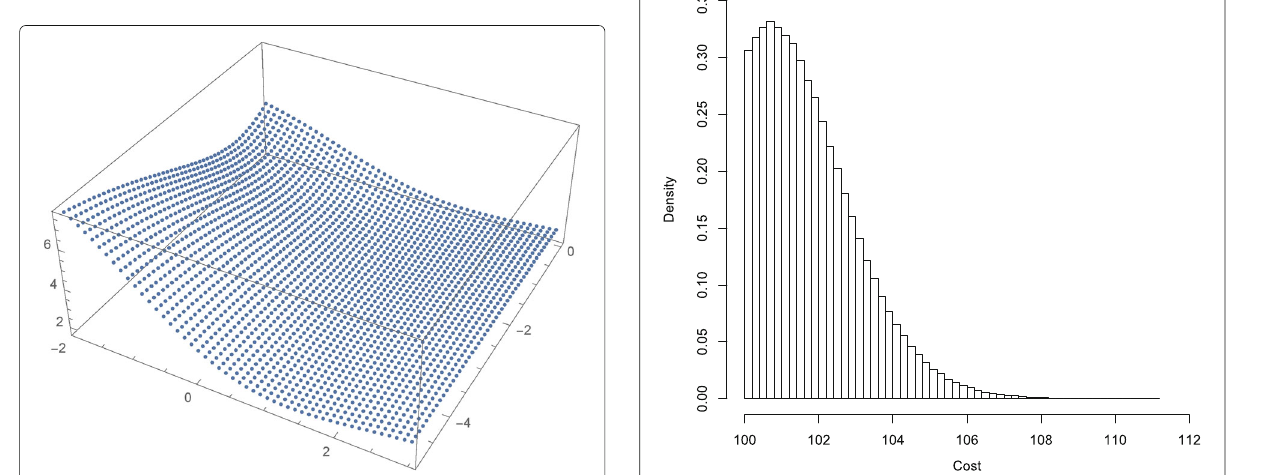
Fig. 4 Histogram for C ( 0.6, − 2 ) . This figure is a histogram for the procurement cost C ( 0.6, − 2